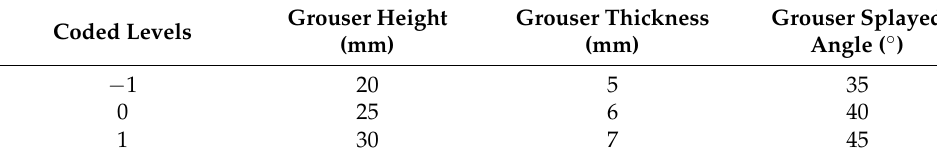
Table 2. Coded levels of independent